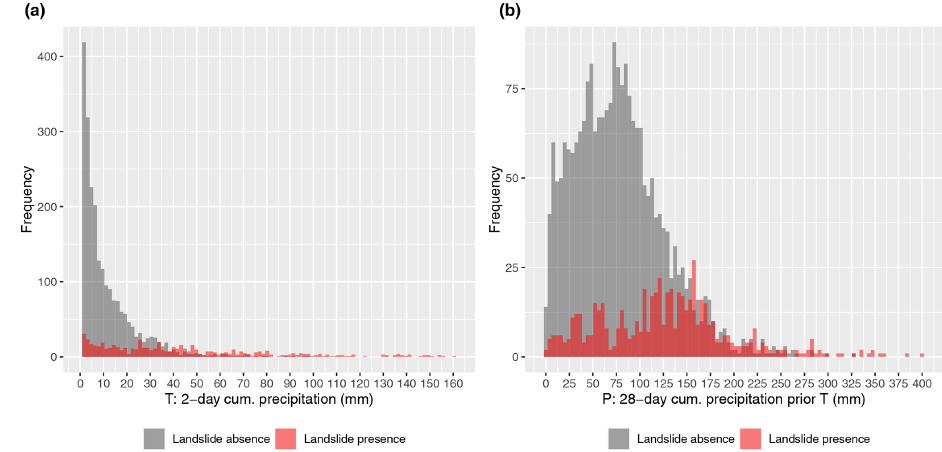
Figure 6. Overlapping histograms for the presence (red) and absence (grey) observations for the two selected precipitation variables T (a) and P (b) . Note that the ratio of presence-to-absence observations generally grows with increasing precipitation values, indicating a trend of increasing landslide occurrence probabilities with increasing precipitation amounts. Table 2. Probability thresholds and associated ROC-based